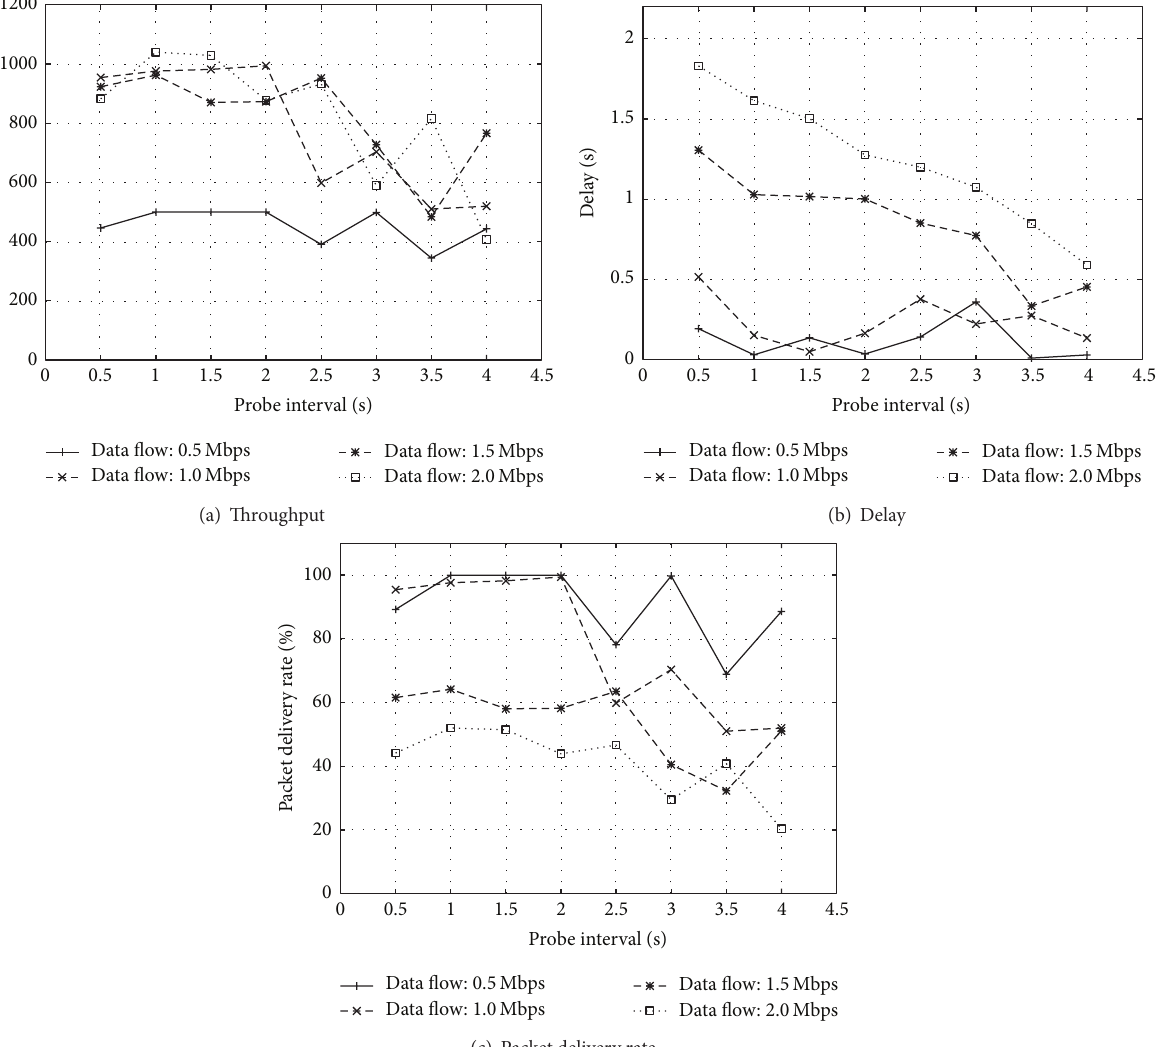
Figure 3: Performance with different probe intervals and data flow